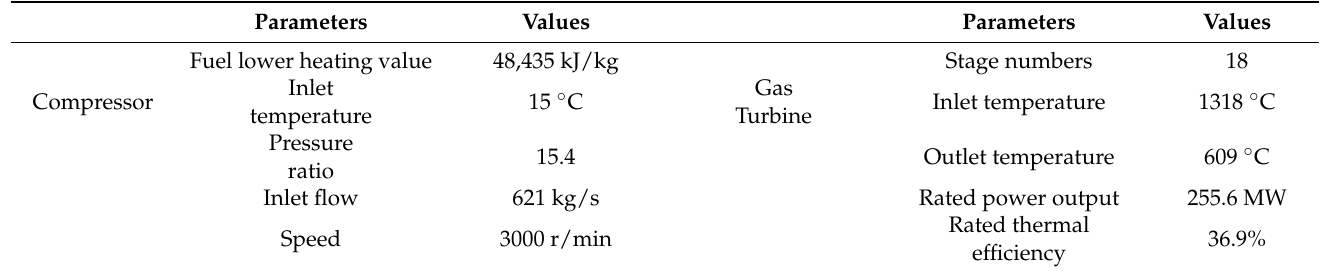
Figure 1. Thermal system flowchart of the CCGT system. Table 1. PG9351FA GT design